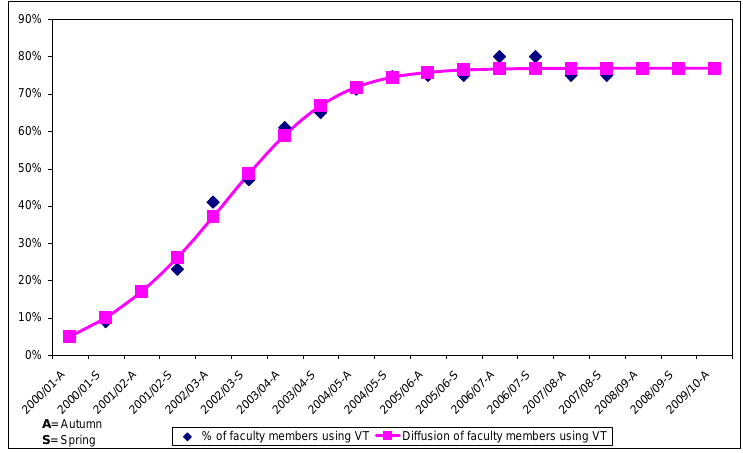
Figure 3 . Virtual TAU diffusion model among instructors according to Bass’s diffusion